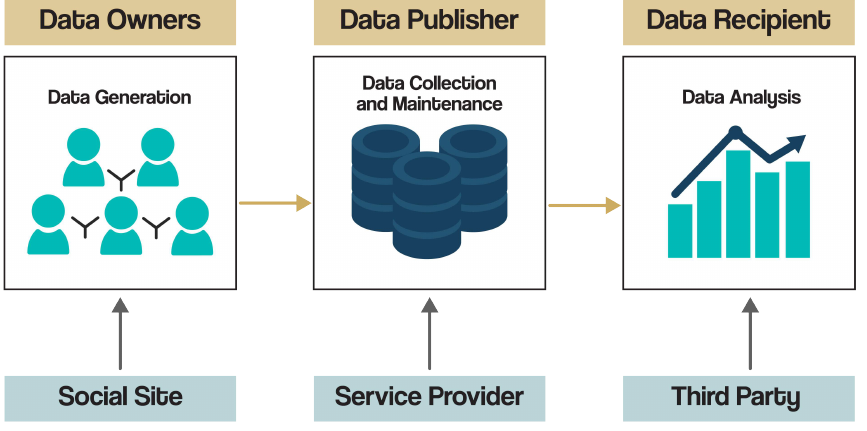
Figure 1. Social networks data publishing